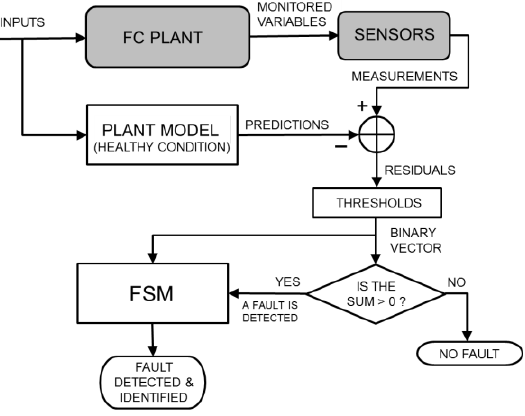
Figure 1. Schematic of the classical model-based FDI strategy for FC plants based on parity equations with output errors [12], residual binarization, and FSM.